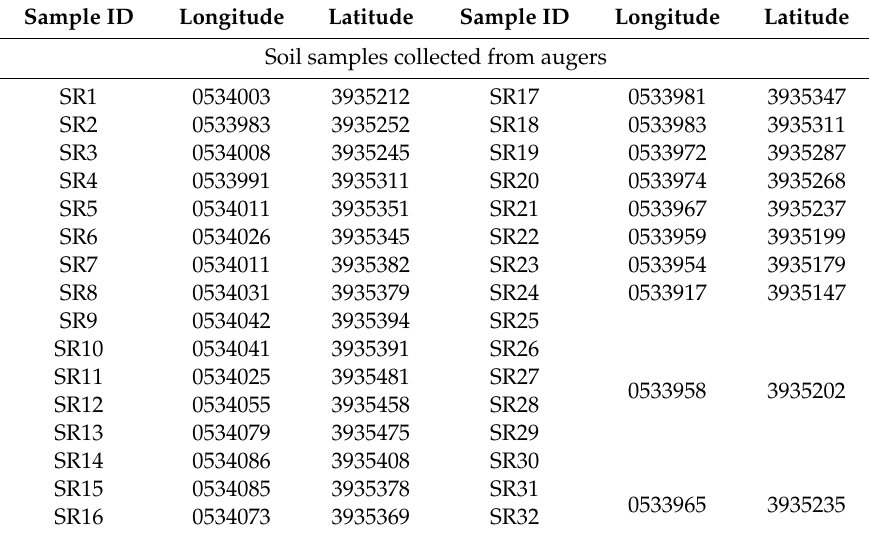
Table 2. Surface and subsurface soil sample geographic locations.